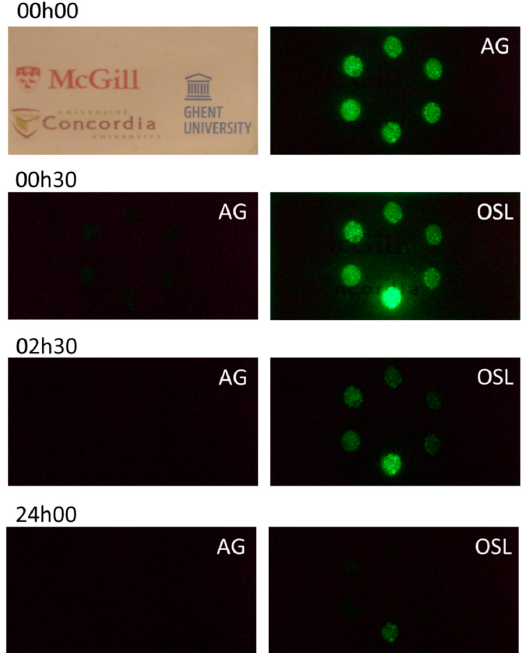
Figure 5. Proof of concept for dosimetric X-ray imaging. A PDMS polymer layer with 1.6 mg / cm 2 phosphor loading (top left) was irradiated by X-rays (~150 Gy) through a mask. Afterglow after ending the X-ray irradiation (top right). Below, the remaining afterglow and OSL (808 nm, 0.50 W / cm 2 ), before and during infrared irradiation, respectively, is shown for 30 min, 2.5 h, and 24 h after the X-ray